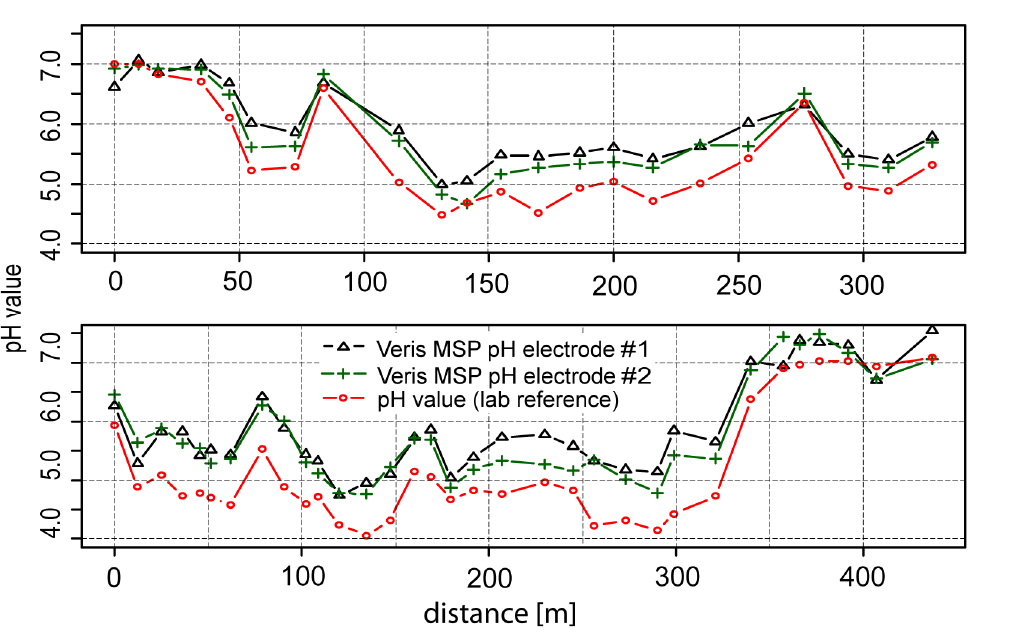
Figure 6. Measurements on two transects with manual control of Veris MSP antimony pH electrodes compared with measurements with glass electrodes in the lab. Soil material was identical for both types of